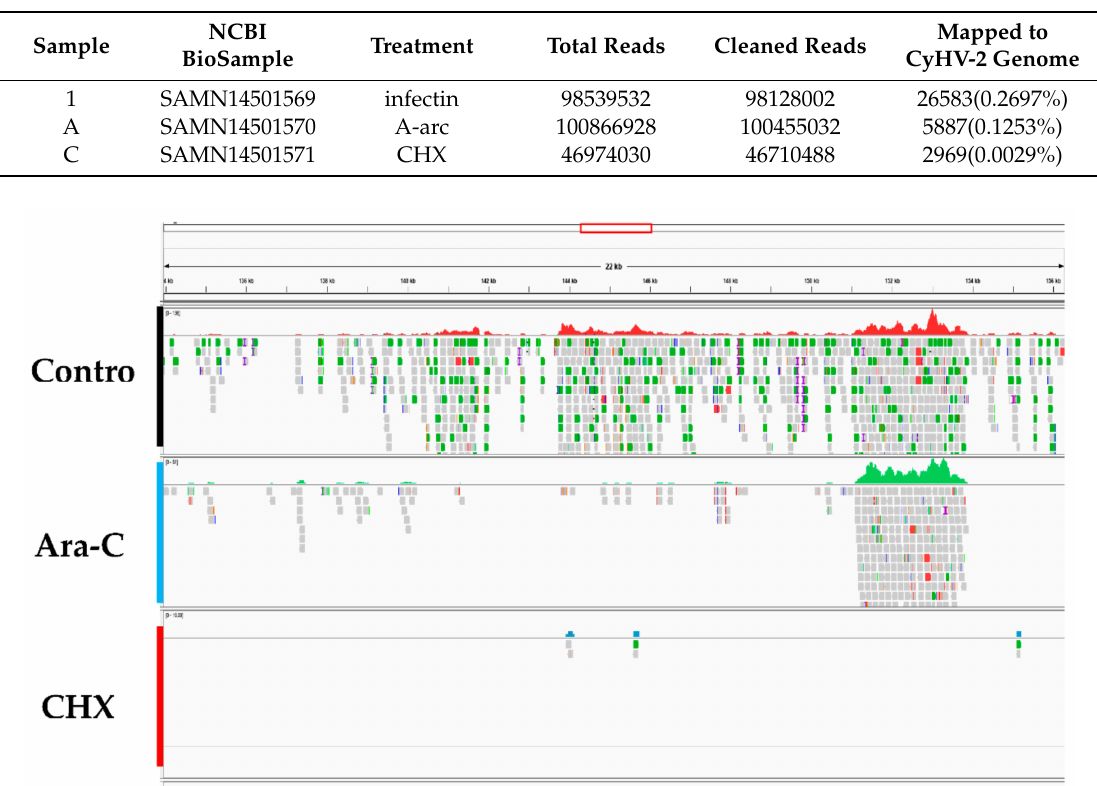
Table 2. Read quality and mapping results for High-throughput sequencing. Group “1”was infected with CyHV-2. Group “A” was treated with 300 µ g / mL A-arc and infected with CyHV-2. Group “C” was CyHV-2 infected, treated with 12 µ g / mL CHX inhibition.